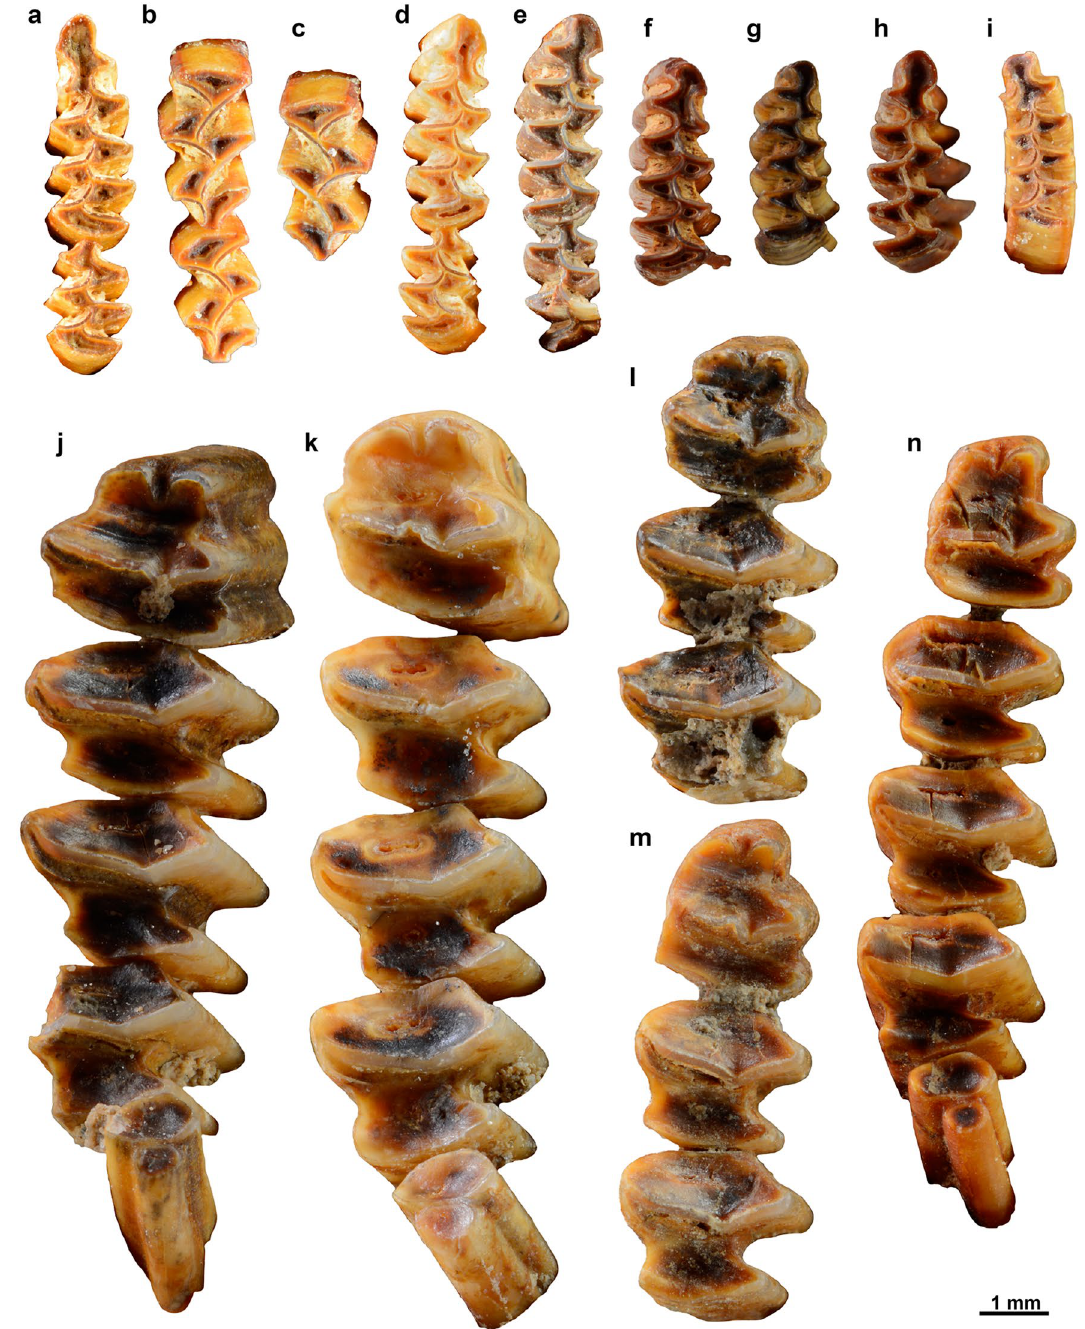
Figure 8. Photographs of the occlusal surface of molars from selected species of small mammals collected at Peña Capón levels 1–6. ( a ) left m1, m2 of Microtus arvalis (level 1); ( b ) M1, M2 of Microtus arvalis - M. agrestis (level 2a); ( c ) upper M1 of Arvicolinae (level 2a); ( d ) right m1, m2 of Microtus agrestis (level 2a); ( e ) right m1, m2 of Microtus agrestis (level 2a); ( f ) m1d of Microtus arvalis (level 2a); ( g ) m1d of Microtus agrestis , juvenile (level 2a); ( h ) Microtus arvalis (level 2b); ( i ) Microtus arvalis (level 3); ( j )–( n ) lower molars of lagomorphs ( j – l level 1; m level 3; n level